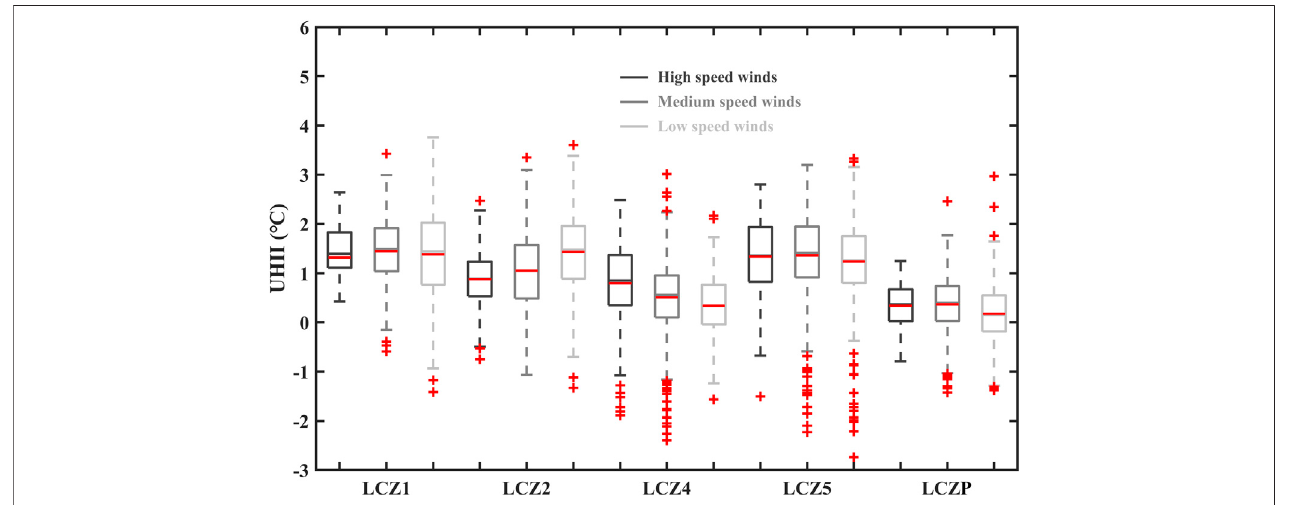
FIGURE 11 | Box-and-whisker plots of the UHII values under different wind speed categories in each LCZ.